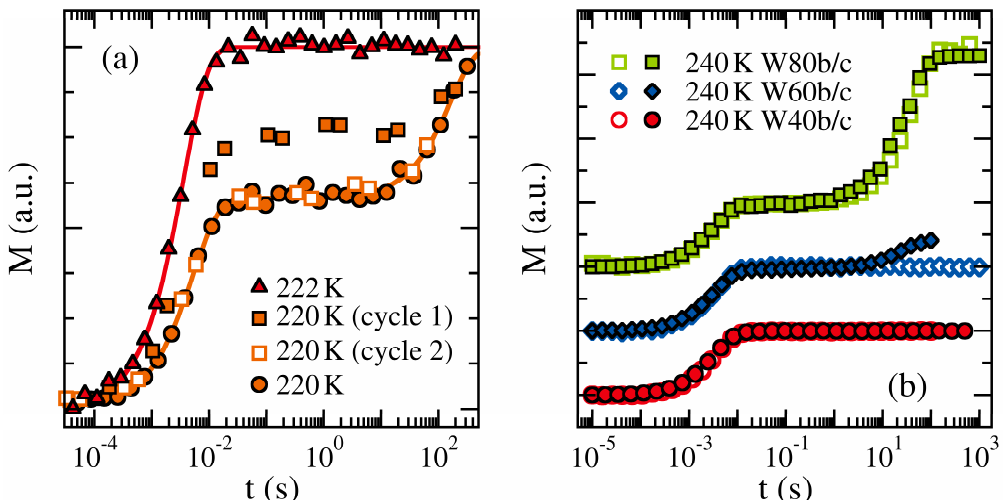
Figure 11. Buildup of 2 H magnetization M(t) for water-glycol mixtures in the bulk and in MCM-41 pores (diameter 2.8 nm): ( a ) Confined PG-D 2 O mixture (45 wt% water) together with fits to monomodal (222 K) and bimodal (220 K) spin-lattice relaxation. At the lower temperature, the relative height of the fast and slow steps differs during the first and second cycles of a staggered-range measurement performed directly after temperature equilibration (squares), while this discrepancy does not occur during a later measurement. ( b ) Bulk and confined PGME-D 2 O mixtures at 240 K. The samples are denoted according to the weight percentages of water followed by the letters ‘b’ and ‘c’ for bulk (open symbols) and confined (solid symbols) mixtures, respectively.